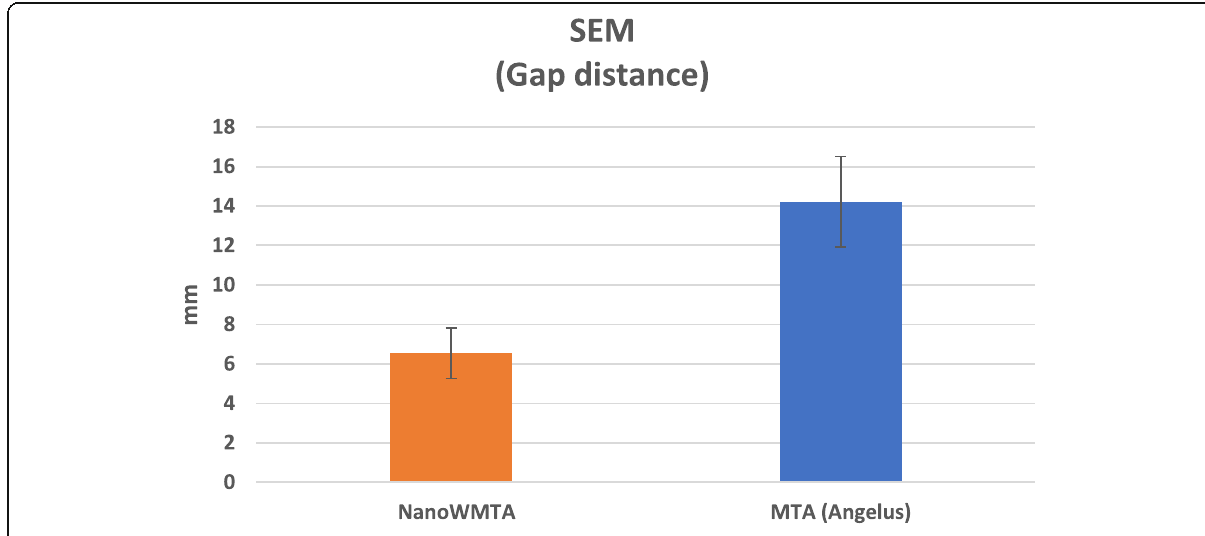
Fig. 2 Histogram showing SEM results for nano-WMTA and MTA